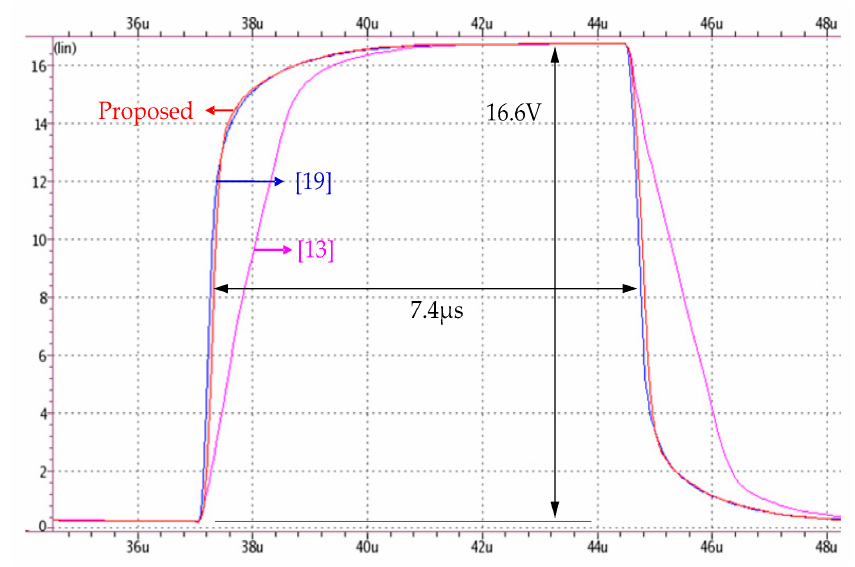
Figure 4. Simulated output waveforms of bu ff er amplifiers. Table 1. Performance comparison of bu ff er